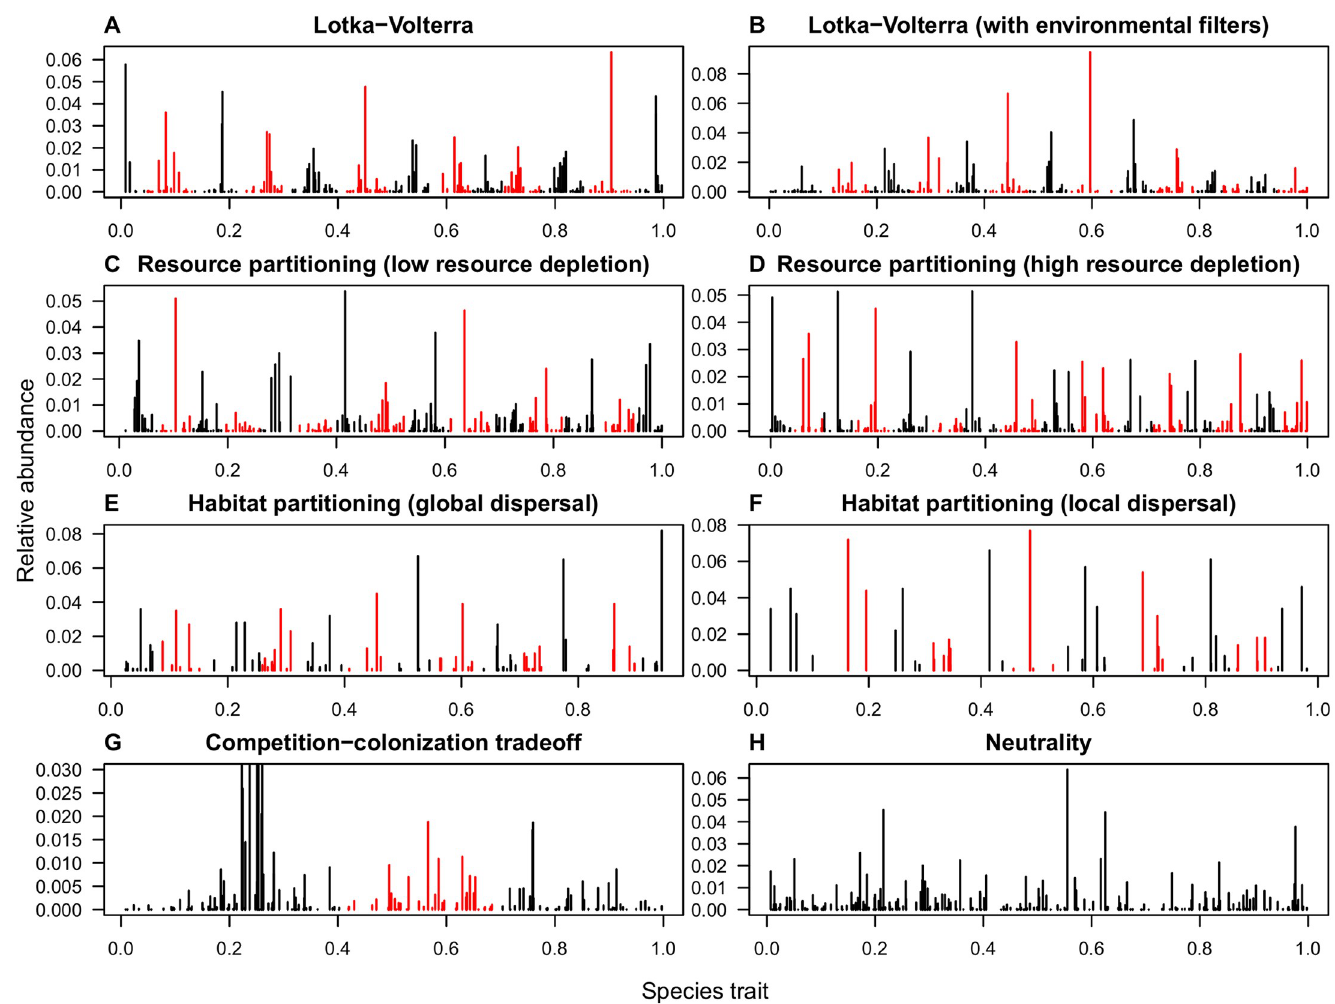
Fig 2. Abundance-by-trait pattern across niche mechanisms. For each scenario (A-H) we show one representative replicate. All communities with a niche mechanism (A-G) are clustered at the p < 0.05 level, while the neutral community (H) is not ( p = 0.1). Alternating black and red colors highlight the clusters. We truncate the y-axis in the competition-colonization tradeoff scenario (G) to better show abundance structure among rare species. (Immigration rate m = 0.08, regional diversity c. 400 species. All communities had 21,000 individuals, except in the partitioning environment scenario, which had 1,000 individuals. Parameters of niche models were tuned so that without stochasticity and immigration they would produce about 13 transient clusters, and eventually 13 species stably coexisting at equilibrium).